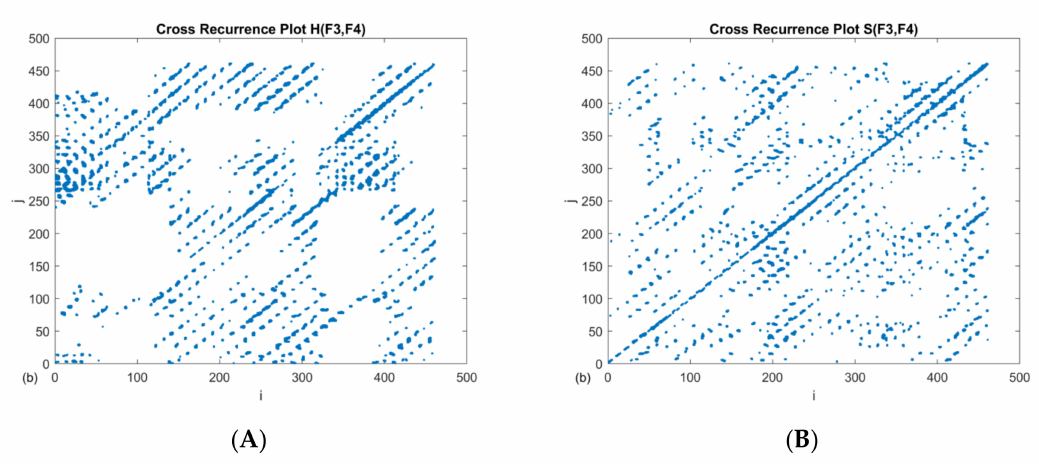
Figure 2. Recurrence plot RP between two electrodes (F3-F4) of filtered and normalized EEG signal for: ( A ) healthy patient, ( B ) patient with schizophrenic. In both cases, same embedding has been used ( τ = 10, m = 5) and same threshold ε =